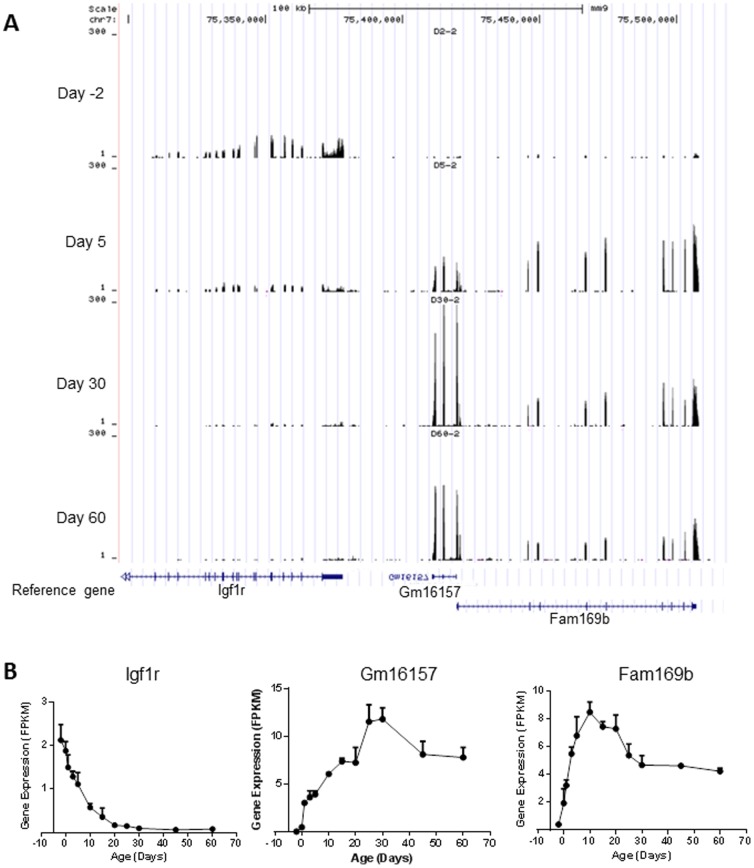
Developmental expression of lincRNA Gm16157 (identified by Ensembl 66) and its neighbor protein coding genes Fam169b and Igf1r.(A) Sequence read distribution at day −2, 5, 30, and 60 viewed by the UCSC genome browser. (B) Gene expression (represented by FPKM) across the 12 selected ages.